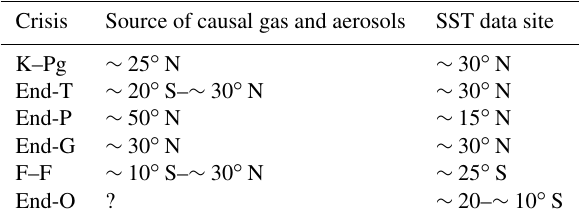
Table 2. Source latitudes of causal gas and aerosols and SST